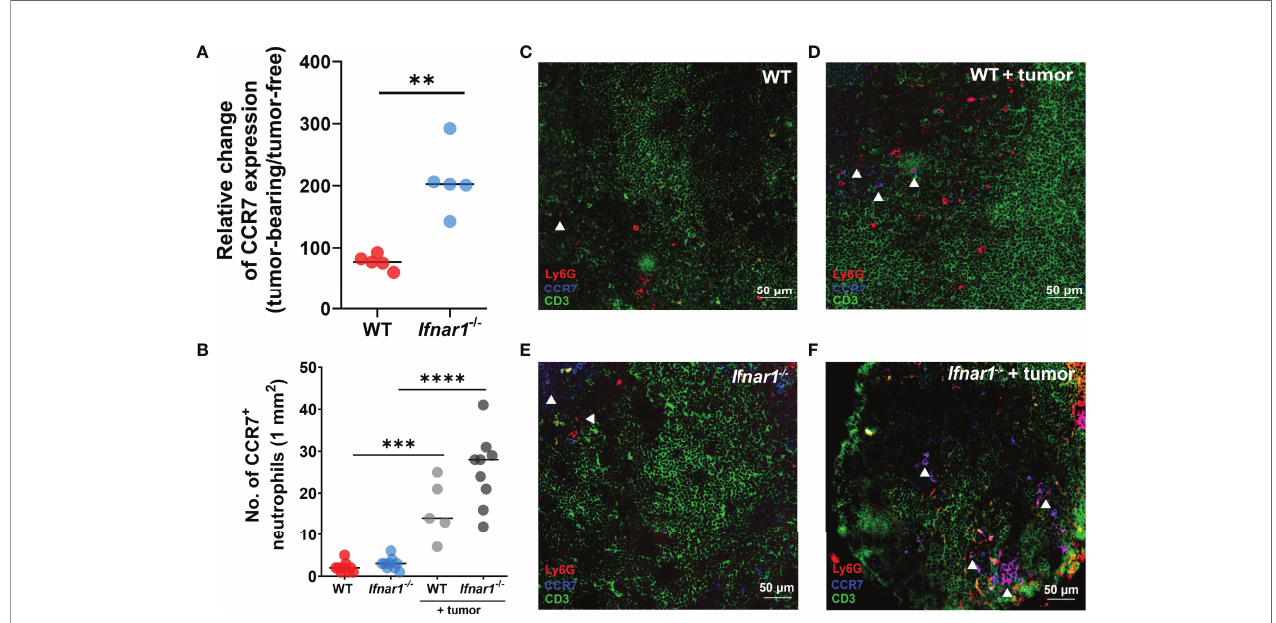
FIGURE 2 | Upregulation of CCR7 expression on neutrophils leads to elevated TDLN in fi ltration by these cells. (A) Elevated expression of CCR7 receptor on neutrophils in TDLNs of tumor-bearing Ifnar1 -/- mice, with relatively higher expression of CCR7 in tumor-bearing animals in comparison to tumor-free animals measured by fl ow cytometry (B) by immuno fl uorescent LN tissue staining. (C – F) Representative images of neutrophil in fi ltration in LNs of tumor-bearing WT (D) and Ifnar1 -/- mice (F) in comparison to tumor-free animals (C, E) . Exempli fi ed TDLN tissues showing immuno fl uorescent stained neutrophils in red, T-cells in green, CCR7 in blue, and CCR7-expressing neutrophils in magenta (indicated by white arrows); an example of single channel staining is presented on Figure S5 . Tumor cells were injected s.c. into the right fl ank of mice. Mice were sacri fi ced on day 14 post-tumor induction, LNs were collected and analyzed using fl ow cytometry and immuno fl uorescent histological staining. Quanti fi cation of neutrophil in fi ltration in TDLNs on cryo-sections, 10 fi elds of view (1mm 2 ) was performed. Representative results from two replicate experiments are shown, n=5 for each cohort. For comparison of two independent groups, Mann-Whitney U test was used. Data are shown as an individual values with median (A, B) . Scale bar: 50 µm. **p < 0.01, ***p < 0.005, ****p <